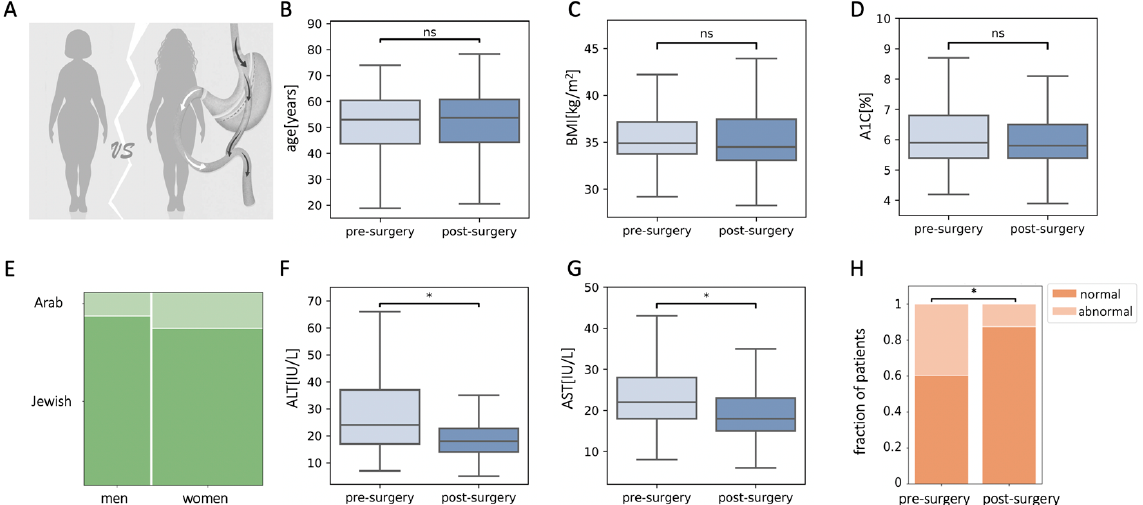
Figure 2. Plasma levels of alanine aminotransferase (ALT) and aspartate aminotransferase (AST) in patients that underwent bariatric surgery were reduced compared to retrospectively matched pre-operated patients. ( A – E ) Characteristics of matched populations: age ( B ), body mass index (BMI) ( C ), glycated hemoglobin (A1C) ( D ), and sex and ethnicity ( E ). ( F , G ) Levels of ALT ( F ) and AST ( G ) were lower in the matched post-surgery population. ( H ) The fraction of patients with abnormal ALT levels were reduced in the matched post-surgical population; ns, non-significant, * p < 0.01 by Mann–Whitney U test ( C , D , F , G ) or χ 2 test ( H ) and Bonferroni correction.